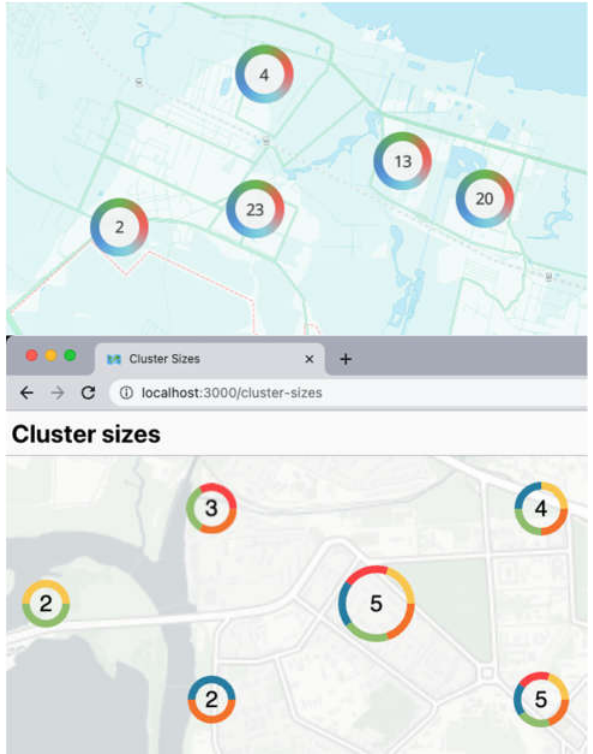
Figure 9 . Comparison of pie charts visualization on Recyclemap.org (top) and map generated by developed library (bottom).